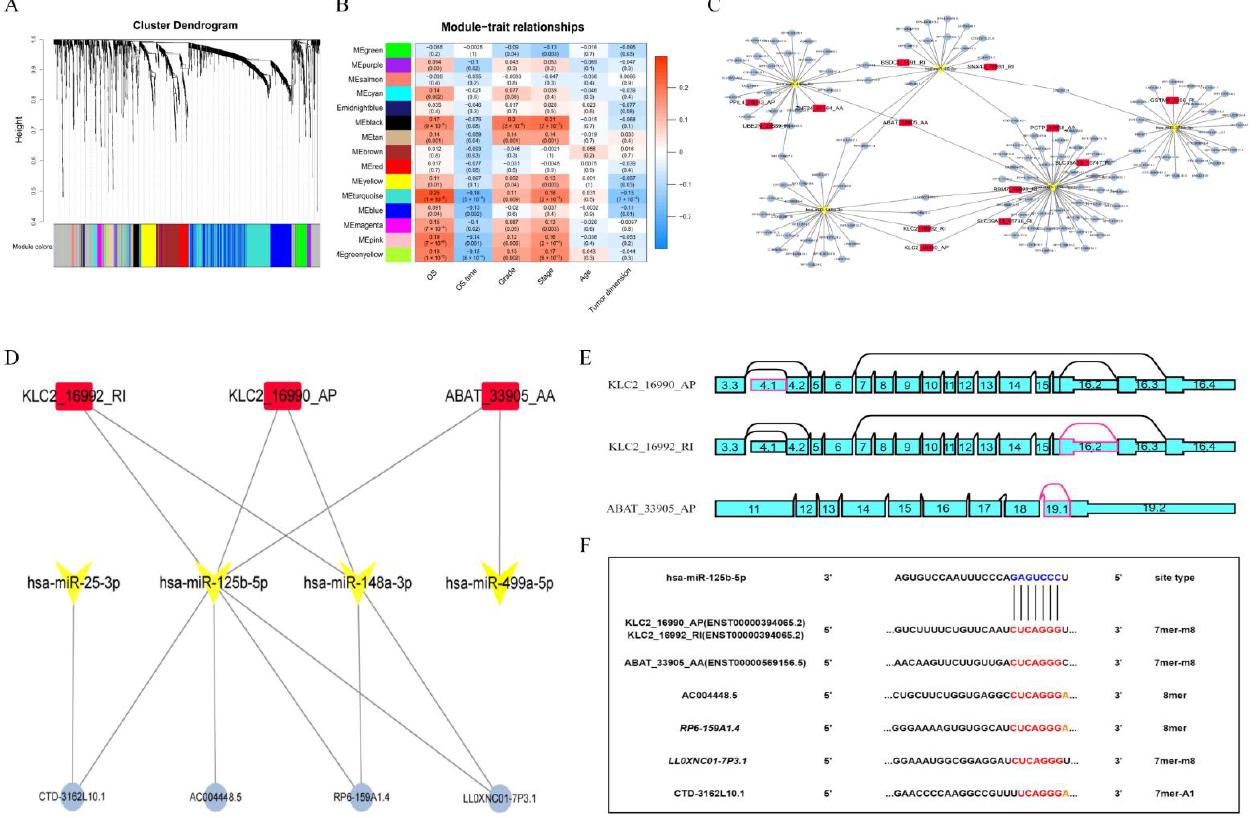
Figure 3. Establishment and analysis of the hub ntRNA–miRNA–lncRNA triple regulatory network. ( A ) Dynamic clustering analysis of genes. ( B ) Module–trait relationship correlation between genes in modules and clinical information. The table’s columns represent clinical data, and each row represents a gene module. ( C ) Triple regulatory network of turquoise modules. Red squares indicate ntRNAs, yellow V-shapes indicate DEmiRNAs, and blue circles indicate DElncRNAs. ( D ) Hub triple regulatory network. ( E ) Splice graphs of three ntRNAs in the hub triple regulatory network. Exons were drawn to scale, and connecting arcs represented splice paths. ( F ) Base pairing between hsa-miR-125b-5p and KLC2_16990_AP, KLC2_16992_RI, ABAT_33905_AP, AC004448.5, RP6-159A1.4, LL0XNC01-7P3.1, and CTD-3162L10.1 predicted by TargetScan and LncBase2.